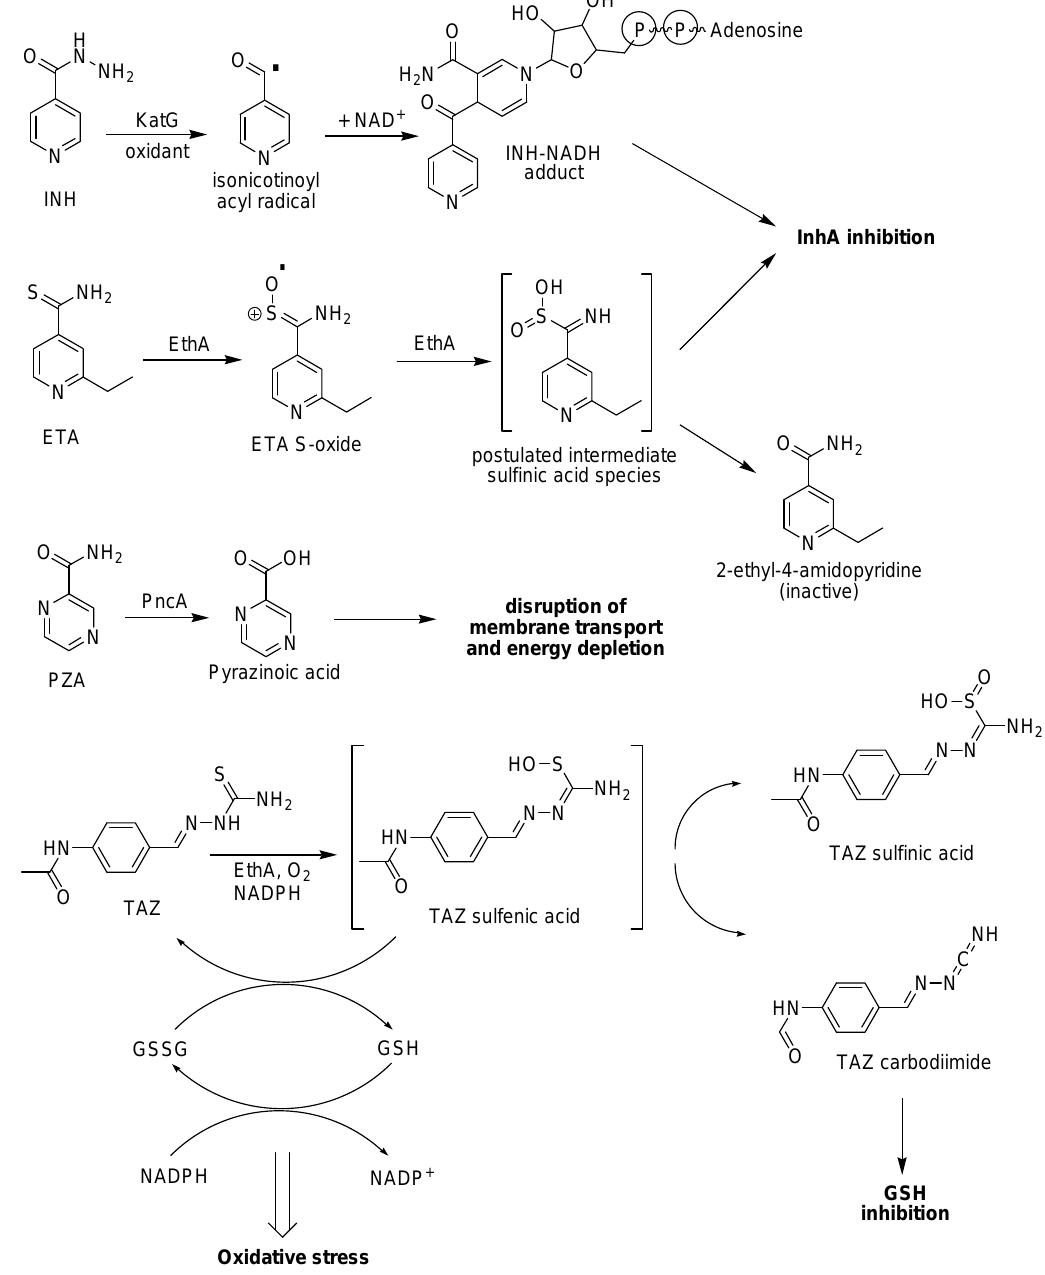
Figure 34 . Activation pathway of the bioprecursors for tuberculosis and targets of the active